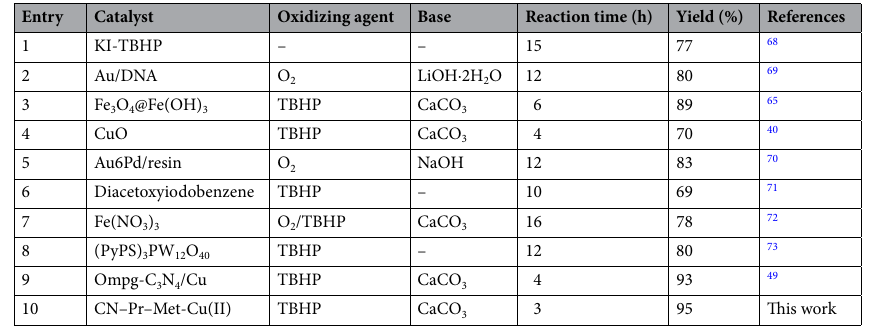
Table 4. Comparison of the catalytic ability of CN–Pr–Met–Cu(II) with previous reports for amides synthesis via the oxidative amidation of benzylic